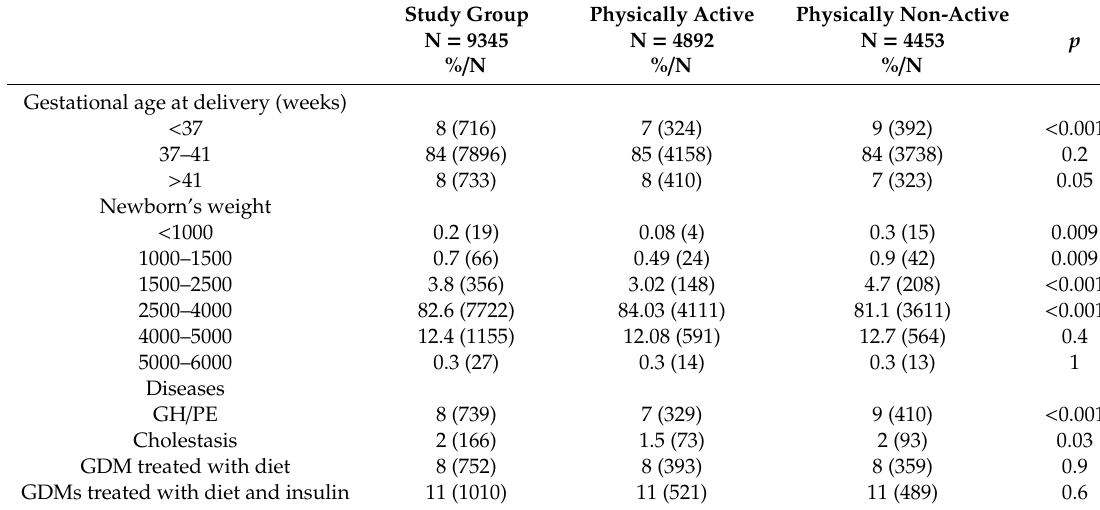
Table 3. Pregnancy complications and course of delivery in the study